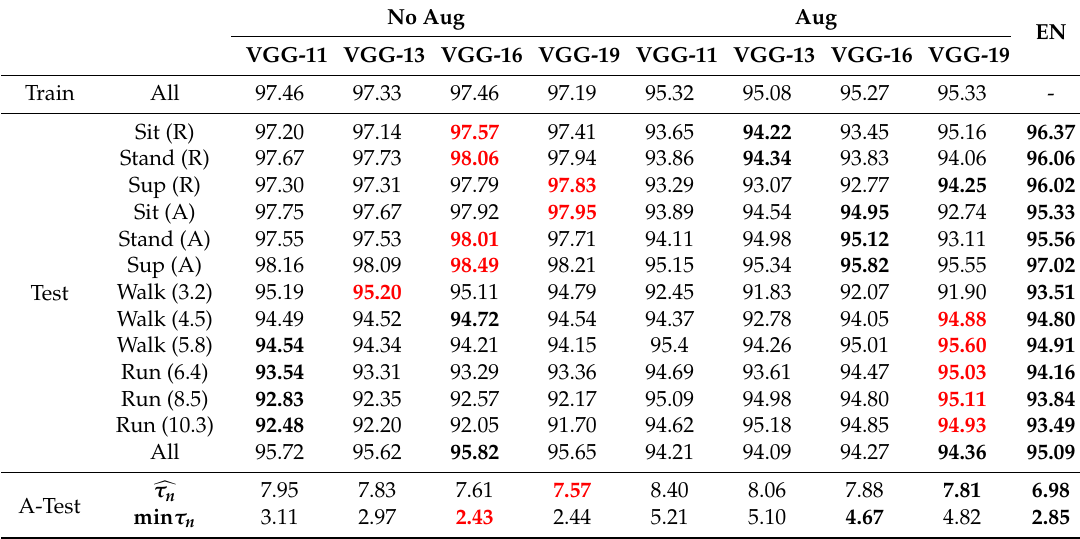
Table 1. Effects of CNN depth and data augmentation according to 12 measurement conditions and results of the A-Test for evaluating structural